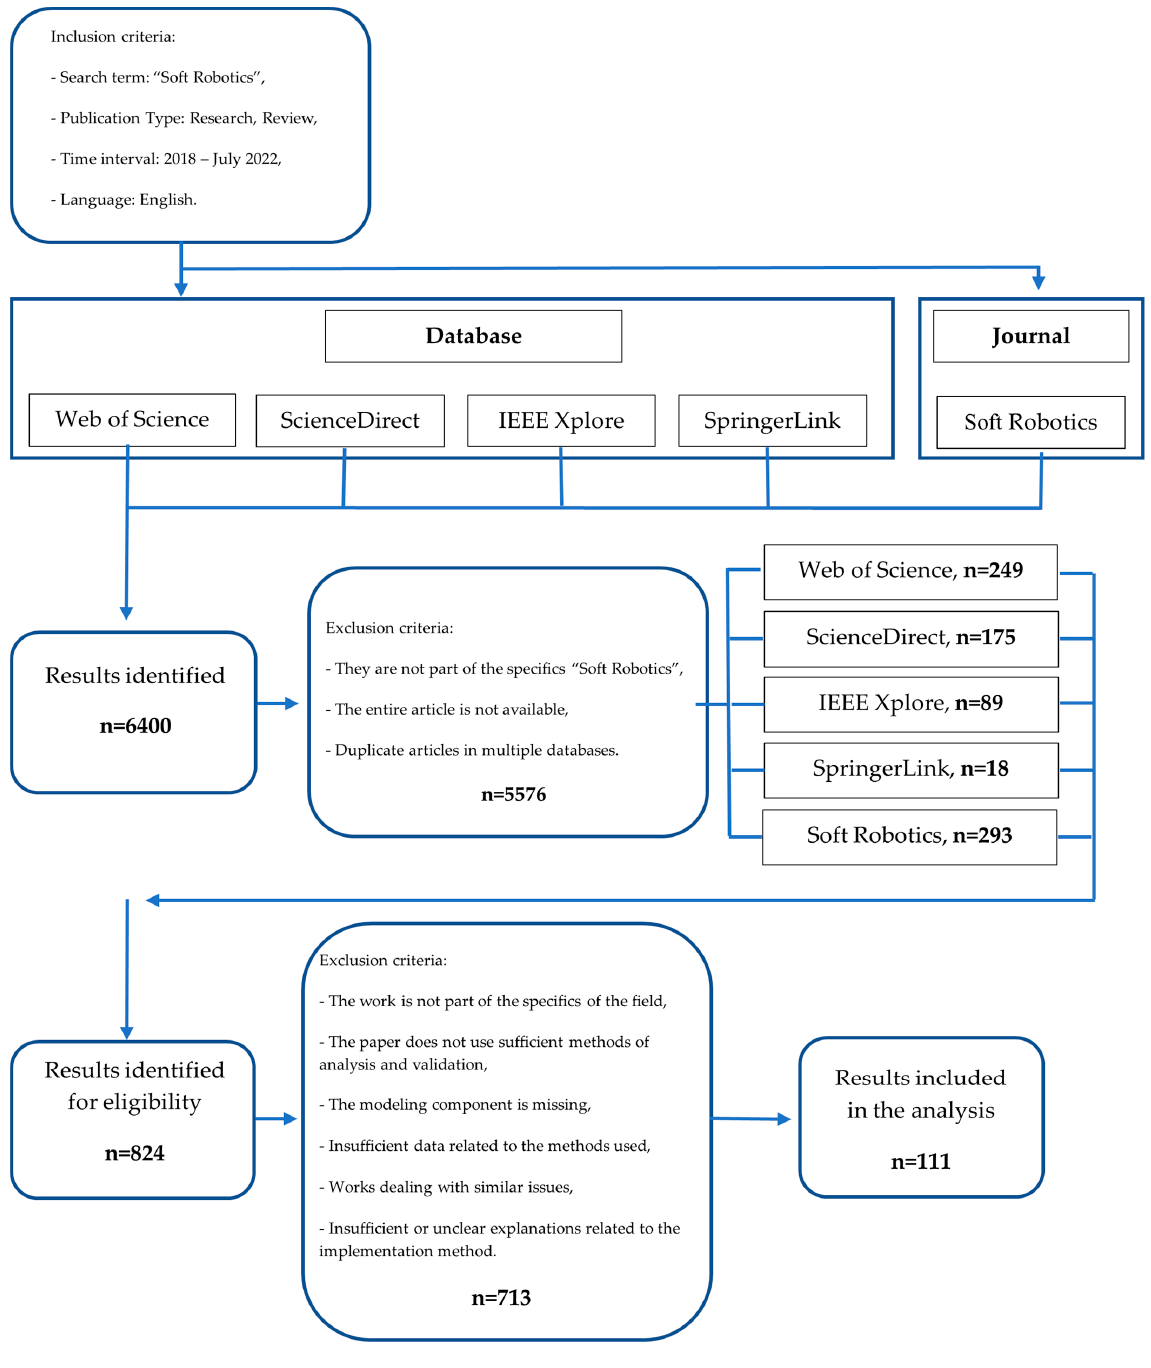
Figure 2. Graph of the selection process of the bibliographic references relevant to this analysis according to [18].